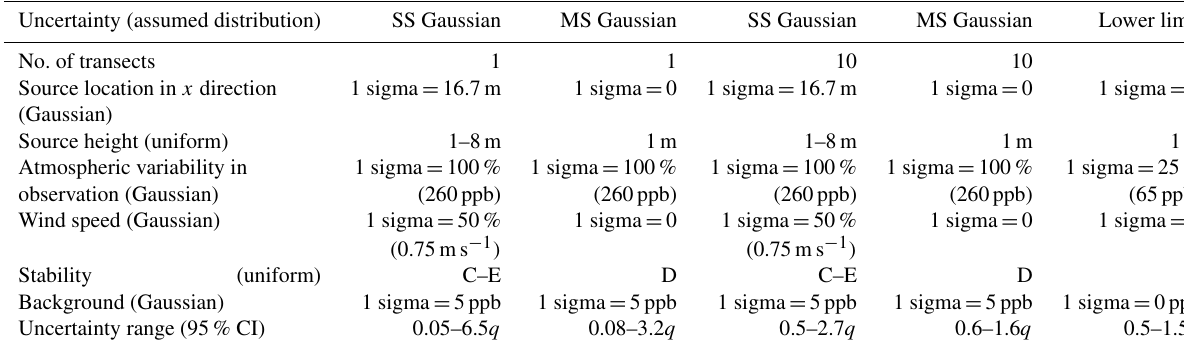
Table 7. Monte Carlo inputs for each uncertainty